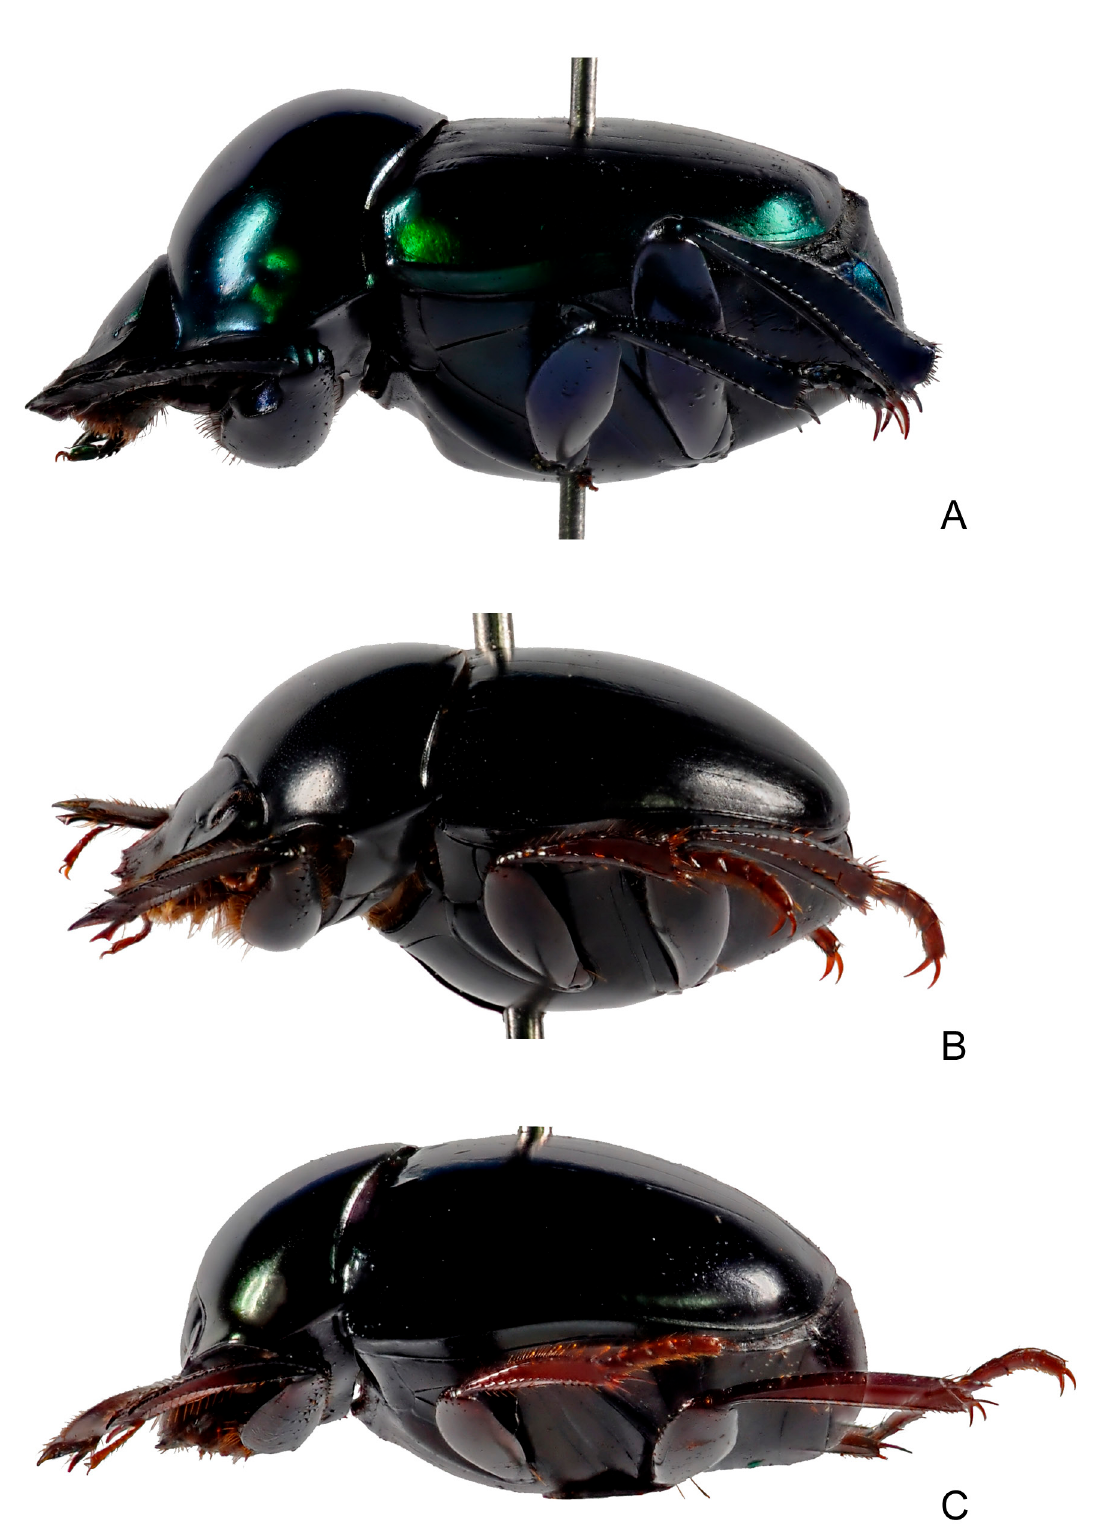
Fig. 10. Lateral view. A . Canthon ( Francmonrosia ) sp. B . Sylvicanthon enkerlini (Martínez et al. , 1964) comb. nov. C . S. candezei (Harold,